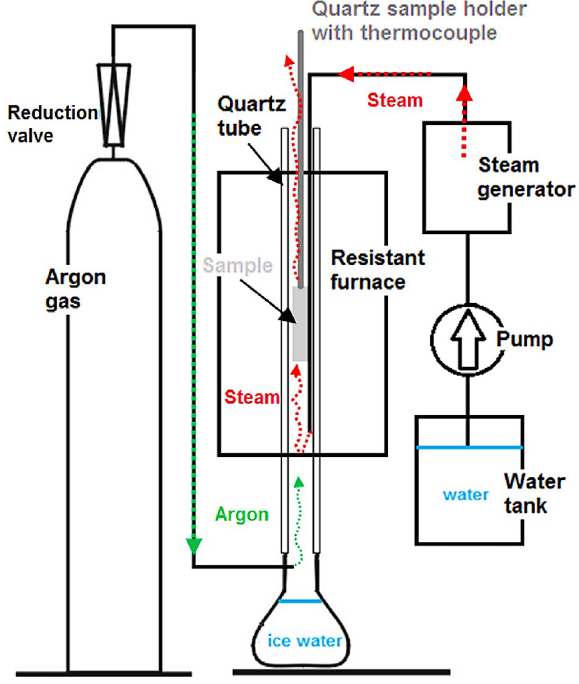
Figure 6. Schematic of the facility for the HT oxida- tion experiment.